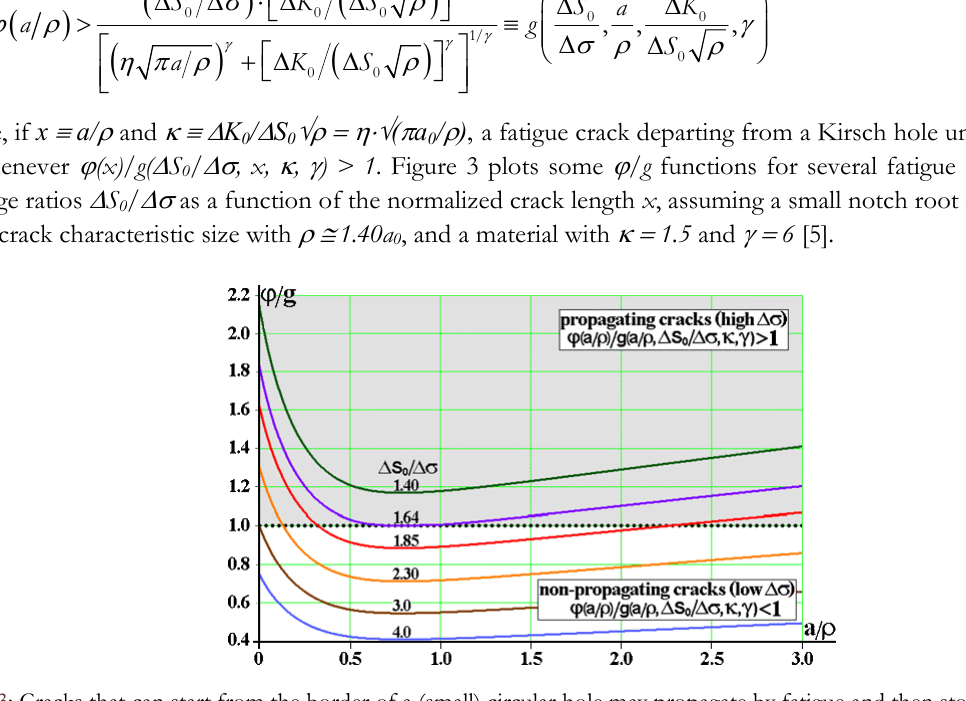
Figure 3: Cracks that can start from the border of a (small) circular hole may propagate by fatigue and then stop if their  /g  < 1 . For high applied stress ranges  , the strength to load ratio  S 0 /  is small, and the corresponding  /g curve is always higher than 1 , so cracks initiate and propagate from this Kirsch hole border without stopping during this process. Small stress ranges with load ratios  S 0 /   K t  3 have  /g < 1 , meaning that such loads cannot initiate a fatigue crack from this hole, and that small enough cracks introduced there by any other means will not propagate at such low